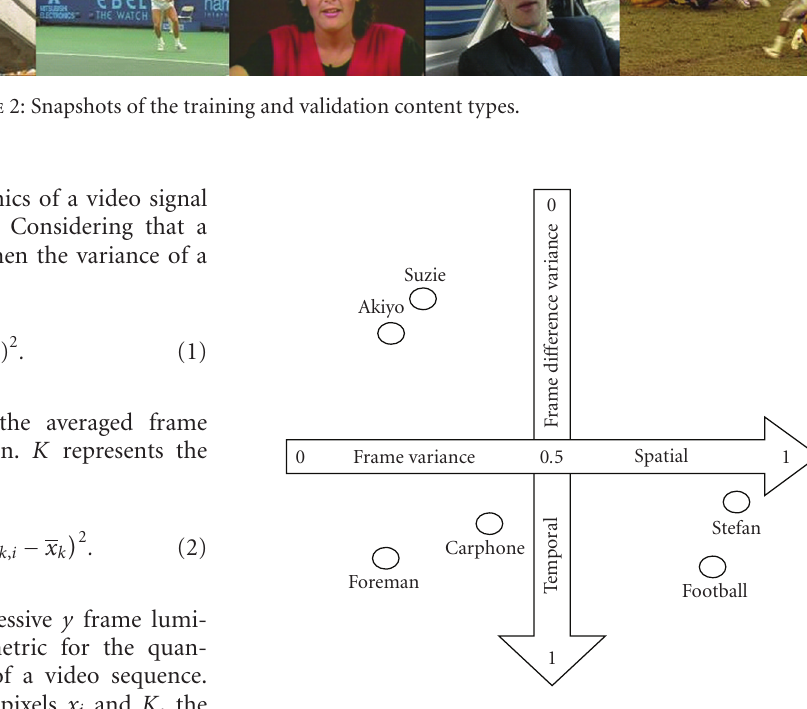
Figure 3: Spatiotemporal classification of the training and valida- tion